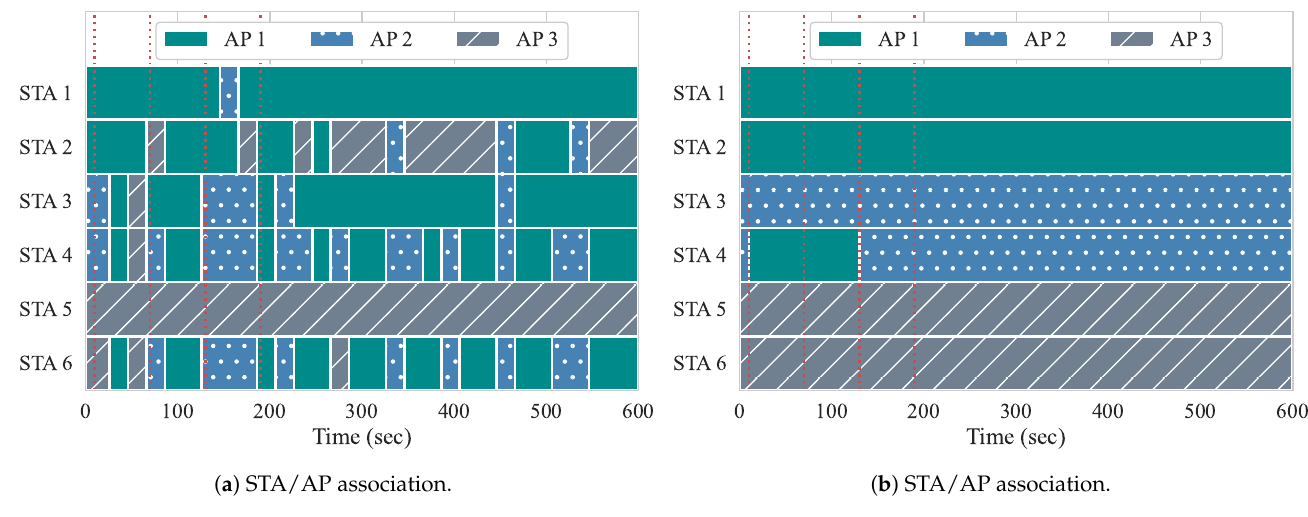
Figure 10. Experiment 2 association. ( a ) Gómez et al. [5]; ( b ) Proposed. At event 1, two DL flows of 20 Mbps each (BE flows 3 and 4) are started from the con- troller to STAs 3 and 4, respectively. Handovers begin to occur with the first iteration